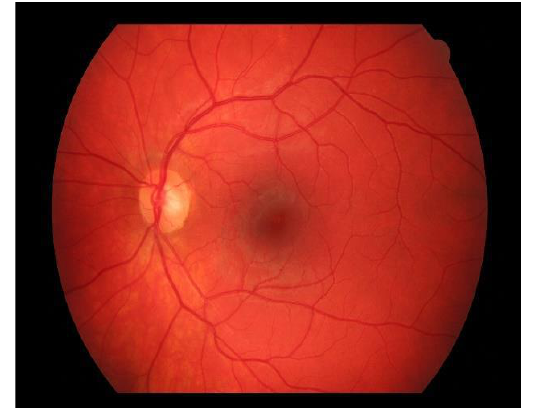
Figure 3.b. Preprocessing